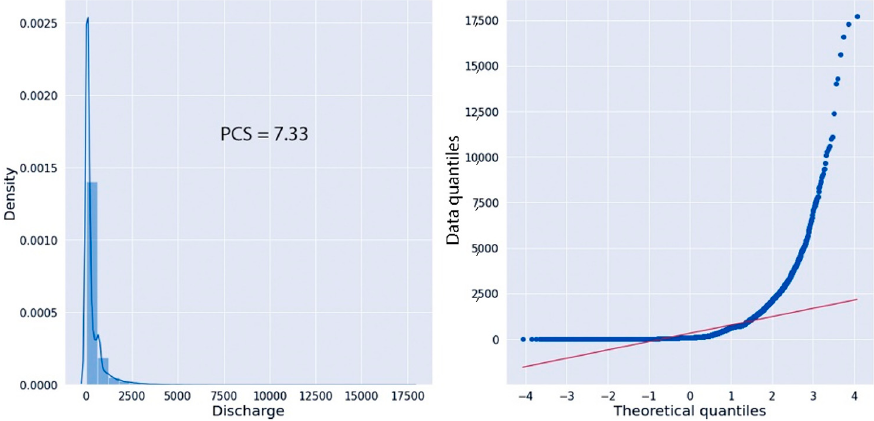
Figure 2. Probability Distribution and Q-Q plot of the discharge series. Table 1. Descriptive Statistics of the entire discharge